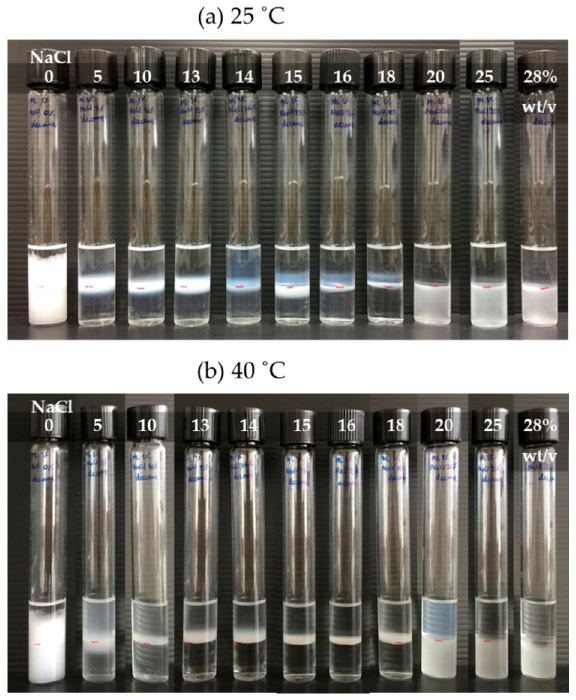
Figure 1. Salinity scans of 1% wt/v AAE(6EO4PO) in the n-decane systems at temperature ( a ) 25 °C and ( b ) 40 °C.